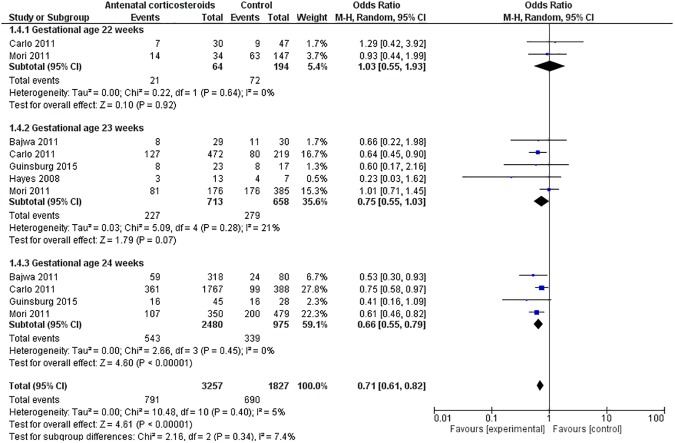
Effect of antenatal corticosteroids on severe IVH/or PVL.